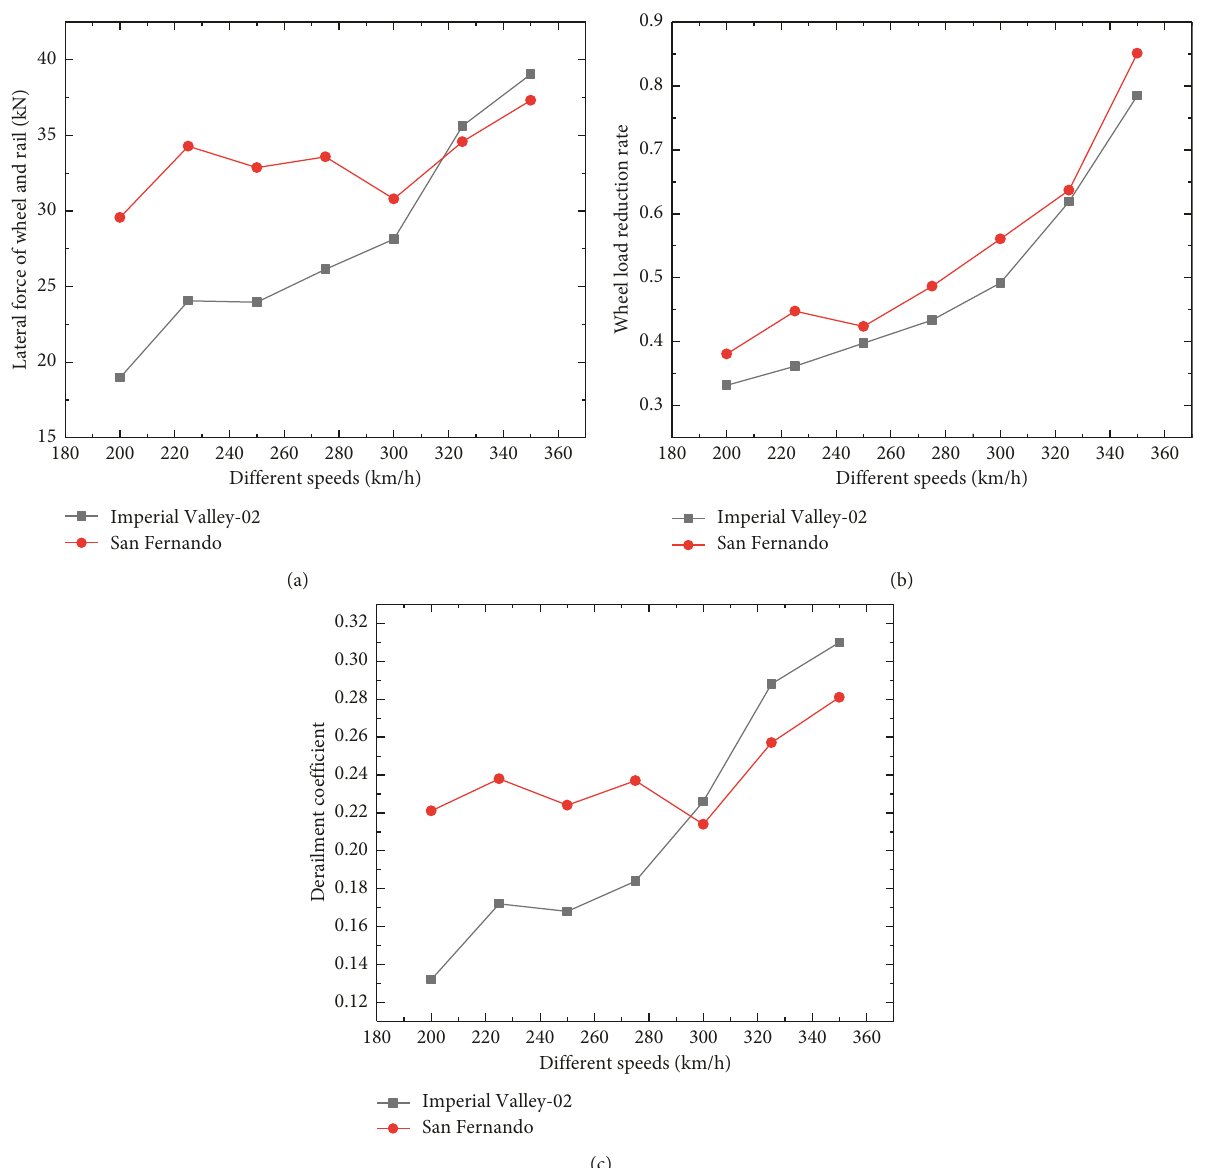
Figure 8: The maxima of wheel-rail lateral force, wheel load reduction rate, and derailment coefficient under different speeds. (a) Lateral force of wheel and rail. (b) Wheel load reduction rate. (c) Derailment